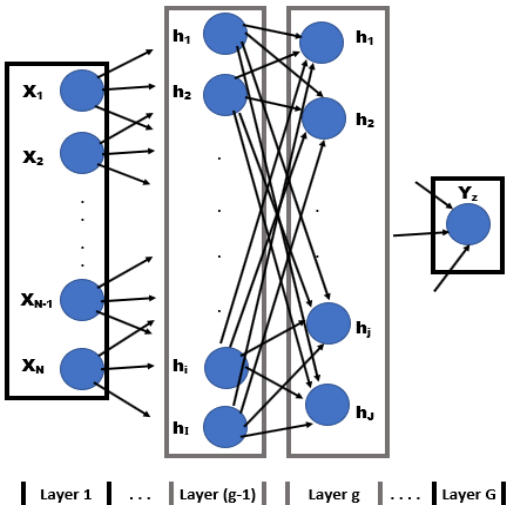
Figure 1. Multi-layered perceptron (MLP) neural network architecture with N inputs, g hidden layers and univariate output.